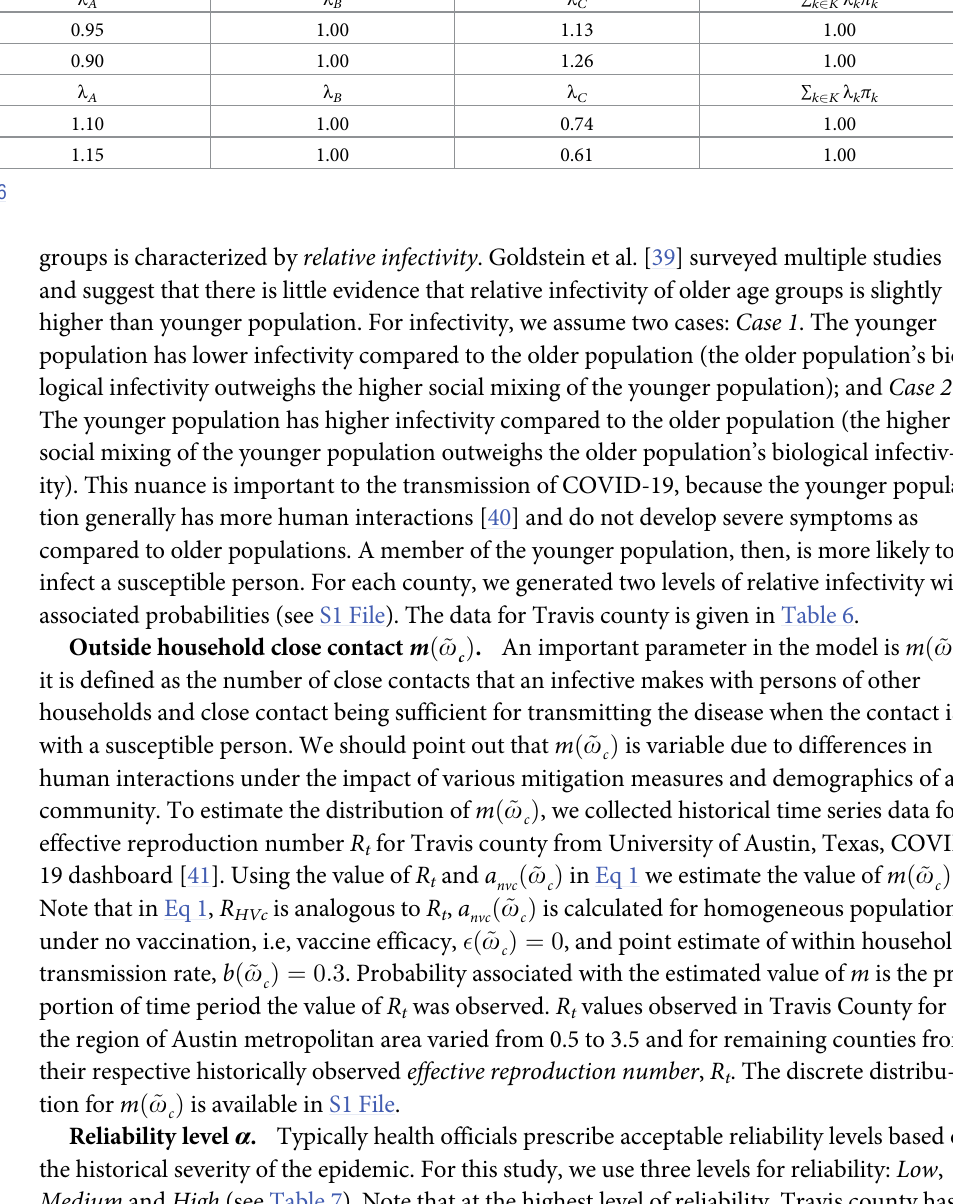
Table 6. Discrete probability distribution of relative infectivity l ð ~ o